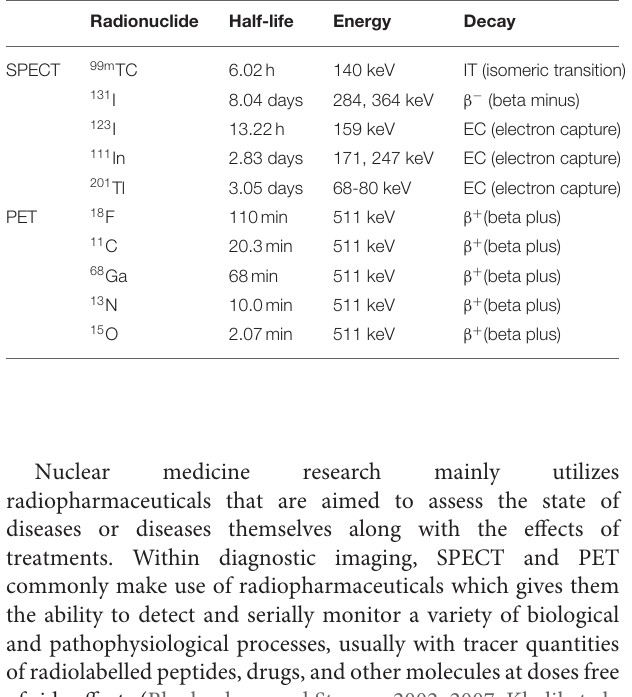
SPECT Longer physical half-lives; multiple radionuclide detection, highest specific radioactivities, modular and more simple chemistry High sensitivity; accurate quantification; diversity of available biological probes